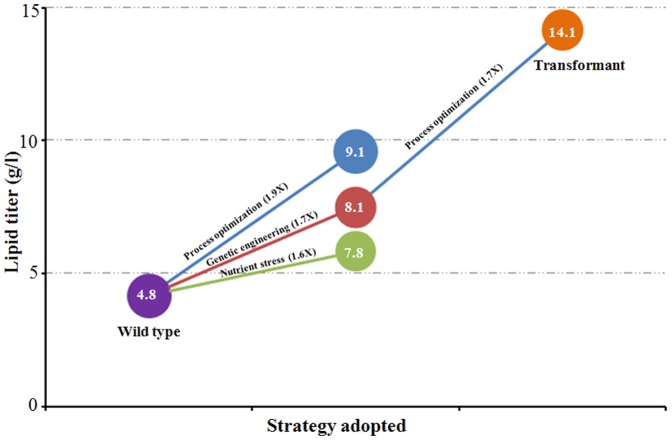
Schematic representation of changes in lipid titer in the wild type and transformed Colletotrichum fungus after adopting different strategies.